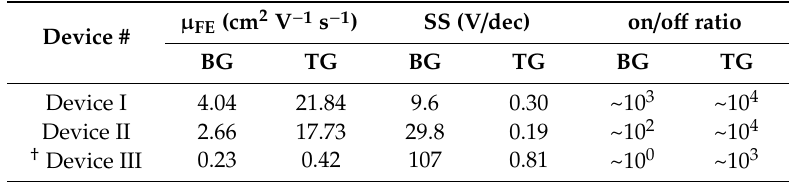
Table 1. Key parameters of CuIn 7 Se 11 -based electric double layer field-e ff ect transistors (EDL-FET). Here, V d = 1 V (Device I) and V d = 0.1 V (Device II and III), SiO 2 thickness = 1000 nm, V d :